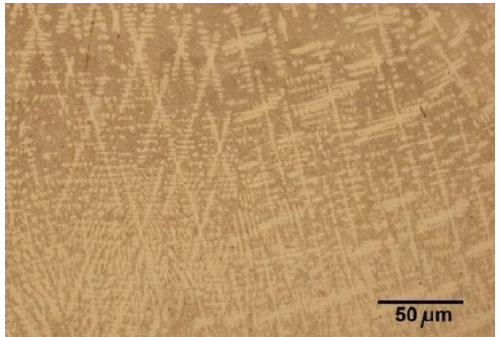
Figure 18. Microstructure of weld metal (OK Tigrod 309L).